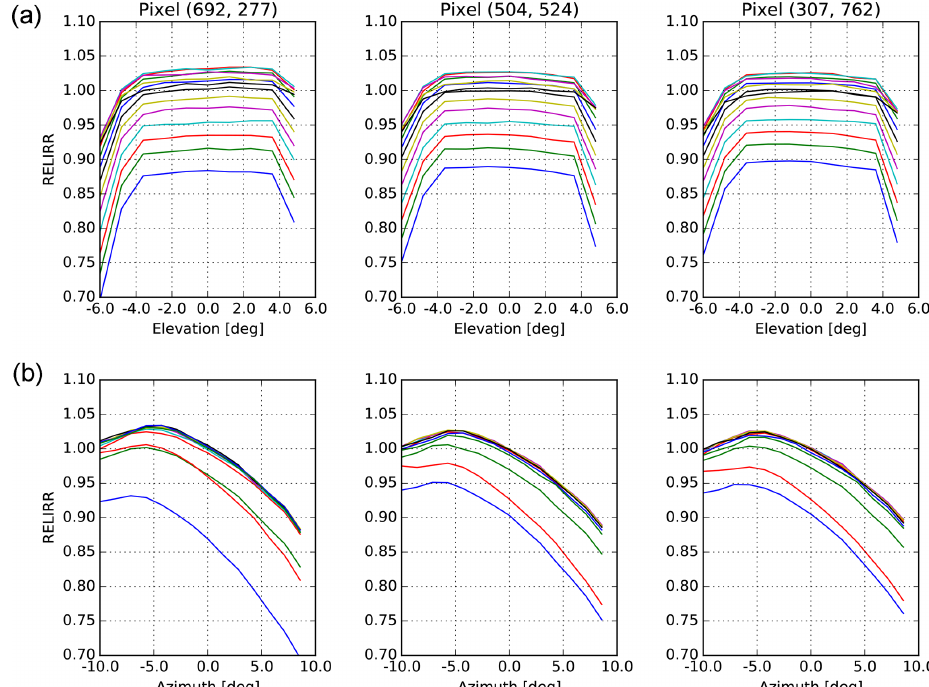
Figure 22. Line plots for selected pixels from Fig. 21. (a) For varying elevation angles; (b) for varying azimuth angles. Lines in each plot are for different azimuth and elevation angles. The relative irradiance as a function of the azimuth angle is smooth and well